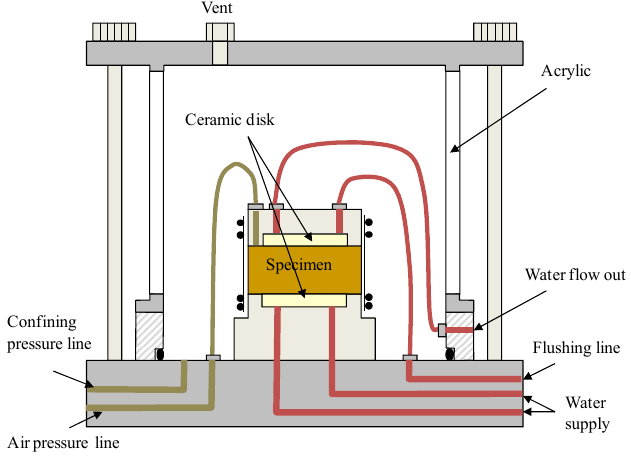
Figure 4. Apparatus to measure the hydraulic conductivities for unsaturated